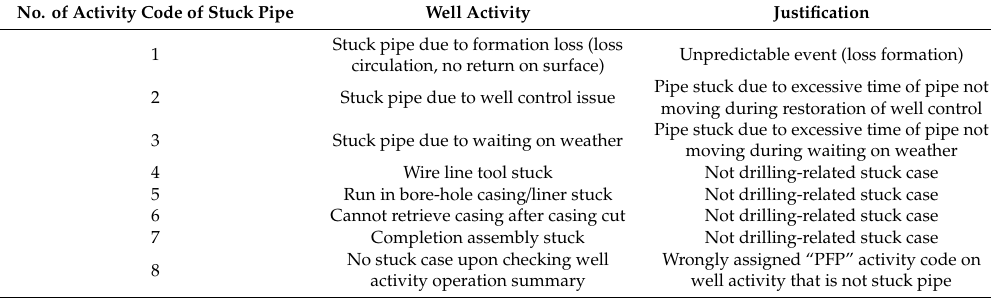
Table 1. Well activities with the “PFP” activity code that were filtered